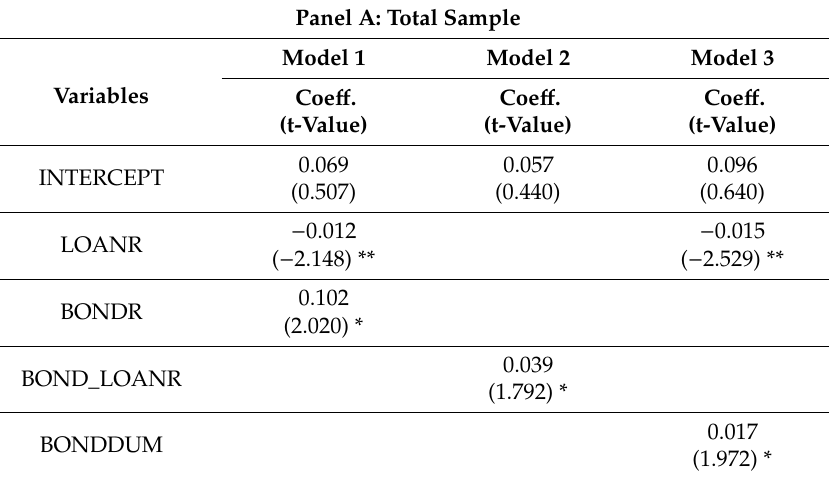
Table 11. Debt origin and investment efficiency: analysis results using the methodology of Gow et al. (2010). Panel A: Total Sample